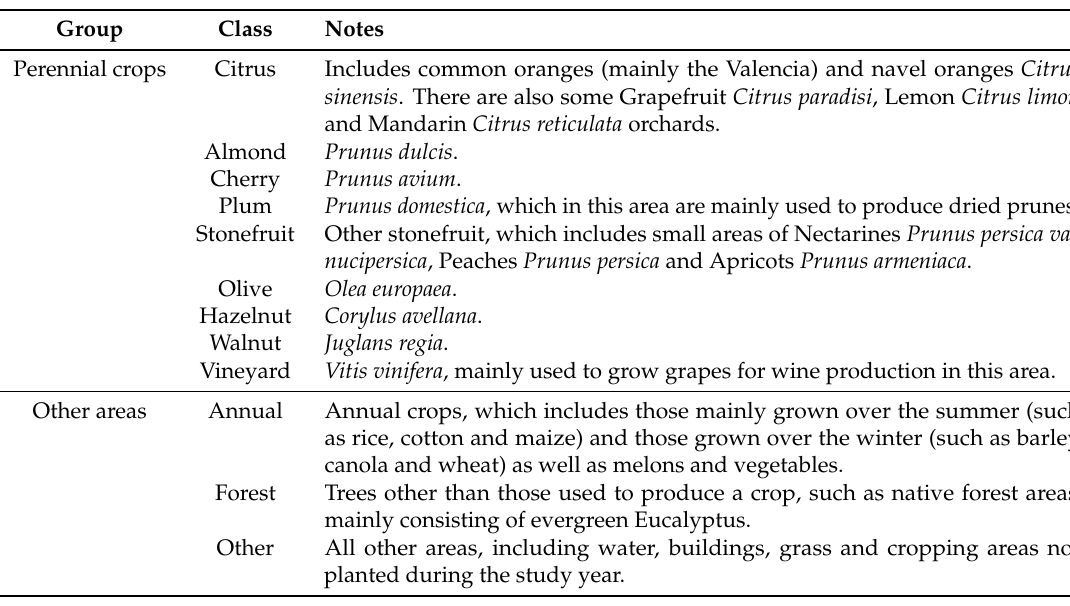
Table 1. Definitions of the nine perennial crop classes and three remaining classes.